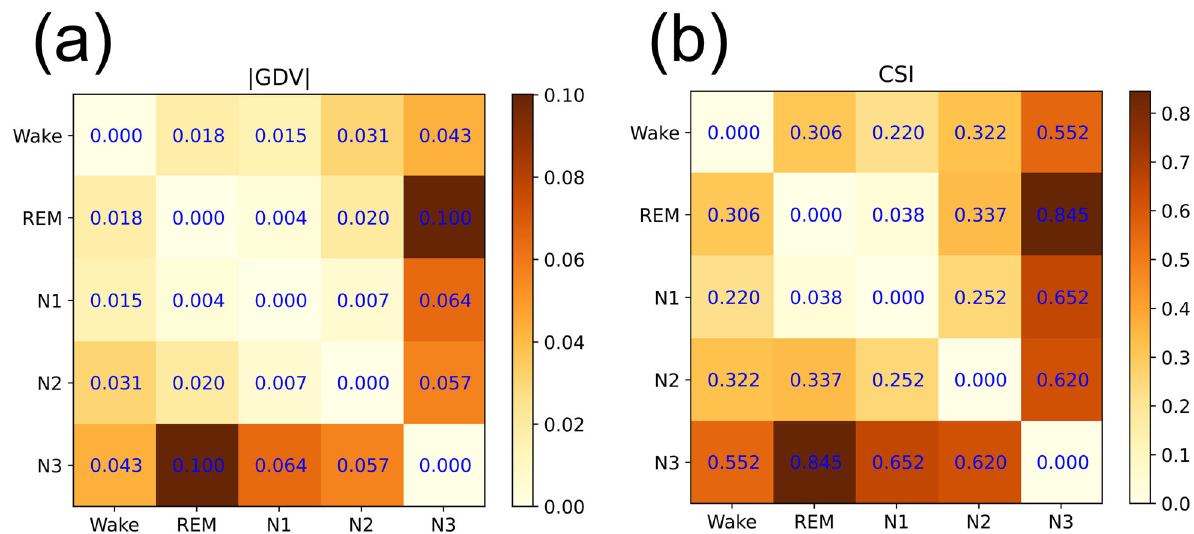
Fig. 8 Mutual distance between sleep stages. Mutual distance between EGG data from different sleep stages, evaluated in the embedding space of the three hyper-parameters STD, KUR, and SKE. The distance matrix ( a ) shows the magnitude of the General Discrimination Value (GDV) and the matrix ( b ) shows the Cluster Separation Index (CSI). In both measures, the minimum distance is found between REM and N1, whereas the maximum distance is between REM and